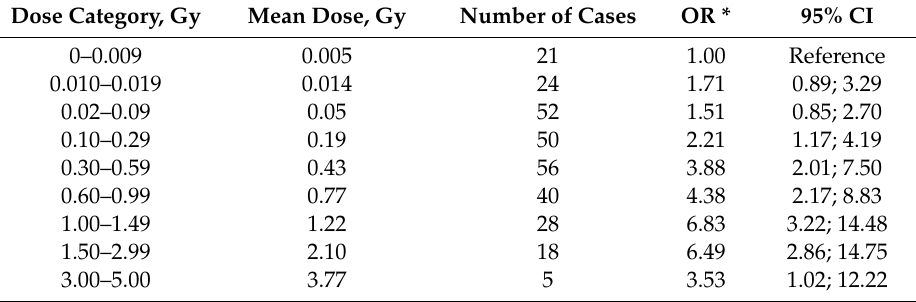
Table 3. Thyroid cancer odds ratios (ORs) and 95% confidence intervals (95% CI) by 131 I thyroid dose